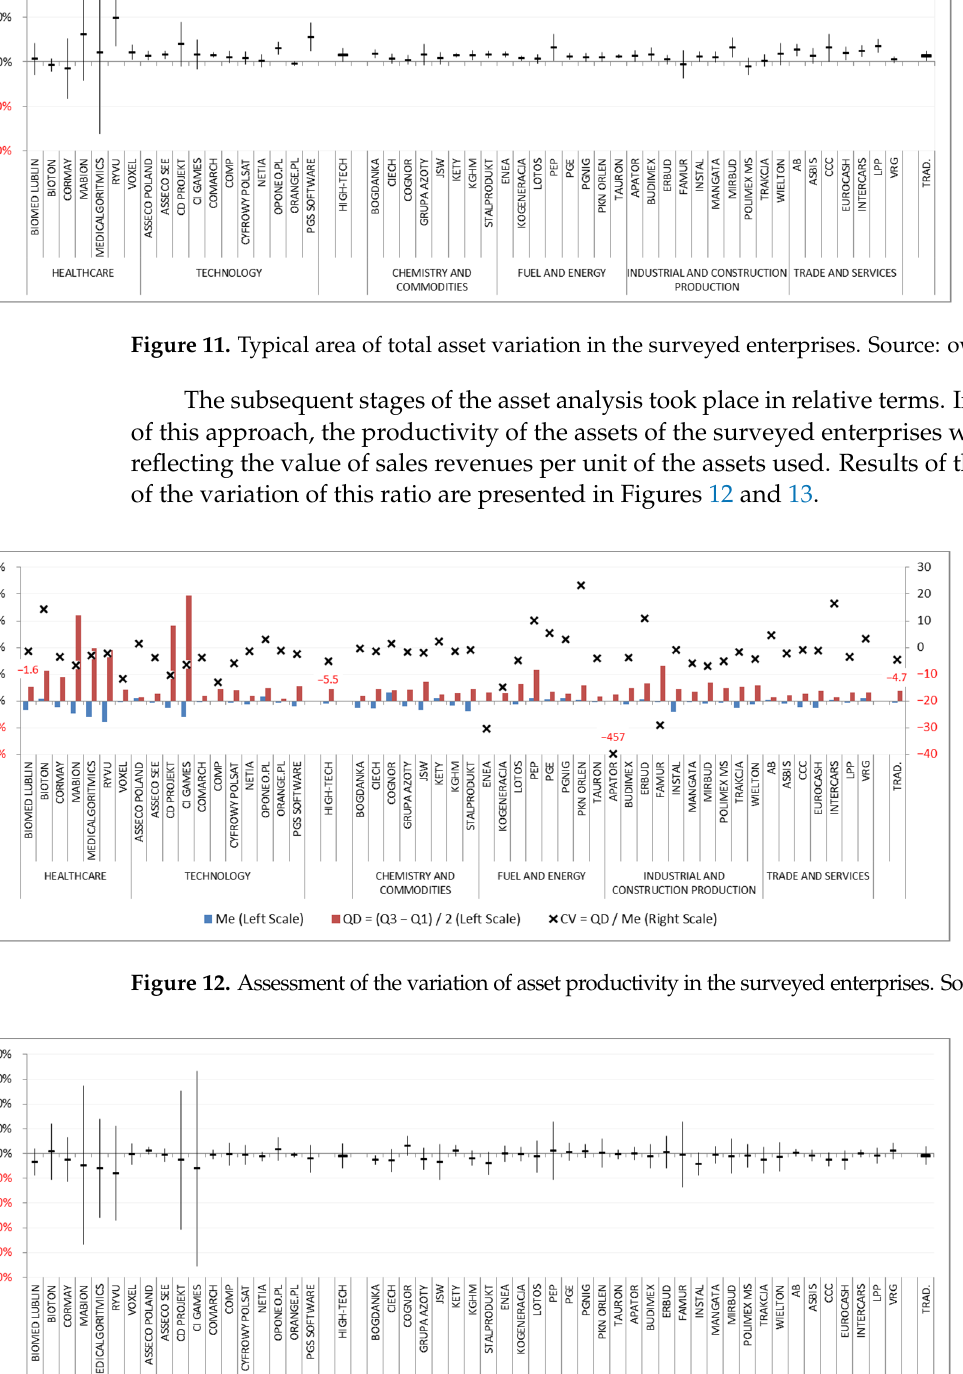
Figure 10. Assessment of total asset variation in the surveyed enterprises . Source: own work.